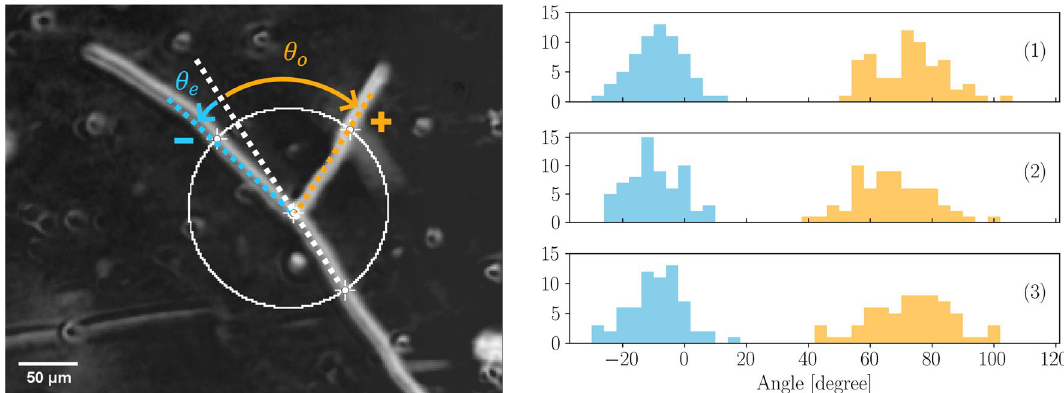
Figure 5. (Left) Typical branching process. A first hypha grows from the bottom right of the image. The branching reveals two new hyphae. A circle of radius R = 80 µ m ∼ 5 hyphal diameters and located on the branching point is drawn. Small angles θ e and wide angles θ o are defined by the intersections of this circle with the new hyphae and the projection of the first (mother) hypha. Following the convention proposed into the text, θ o > 0 and in this example θ e < 0 . (Right) (1), (2) and (3) are representations (pdf) of the populations of 66 measurements of the small angle θ e (in blue) and the wide angle θ o (in orange), defined in regard to the extension of the mother hypha, see the image on the left for details. Bin width is 4° in this representation. Gaussian fit lead to respective means for small angle − 8.5 ± 4.2 , − 10.2 ± 4.2 and − 9.2 ± 4.2 , and for wide angle 72.6 ± 4.1 , 67.1 ± 4.3 and 73.2 ± 4.2 apical branching. By observing the dynamic branching process real V 3 vertices can be segregated from the geo- metric vertices V 3 i due to overlapping intersections. The comparison between images acquired before and after the branching allows the operator to extract a real V 3 vertices collection without any ambiguity. The procedure of angles extraction is shown in Fig. 5. A circle with a radius of 50 pixels (approximately five hyphal diameters) is centered on each V 3 vertex. The coordinates of the points of intersection between the circle and the three hyphae are manually recorded. For each apical branching, the extension of the mother hypha in the direction of growth determines two angles with both emergent hyphae, a small angle and a wide angle. From the complete network, 66 V 3 were extracted from each experiment. We then considered two populations, respectively composed of the collection of the small angles θ e and of the wide angles θ o (Fig. 5). The uncertainties on each angle value δθ = 4